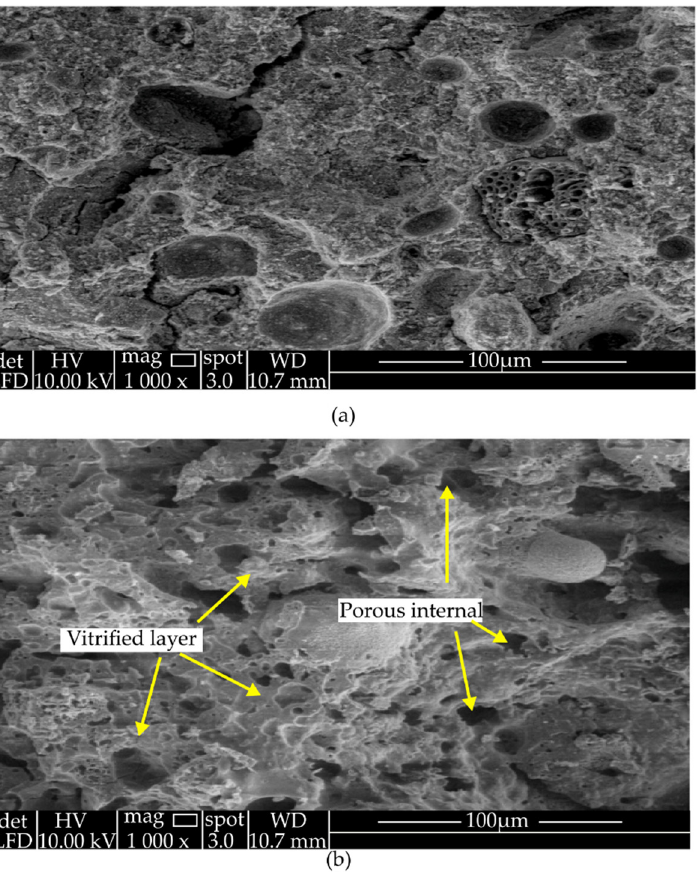
Figure 2. SEM micrograph of POFA aggregates ( a ) before sintering and ( b ) after sintering with magnification ×1000.